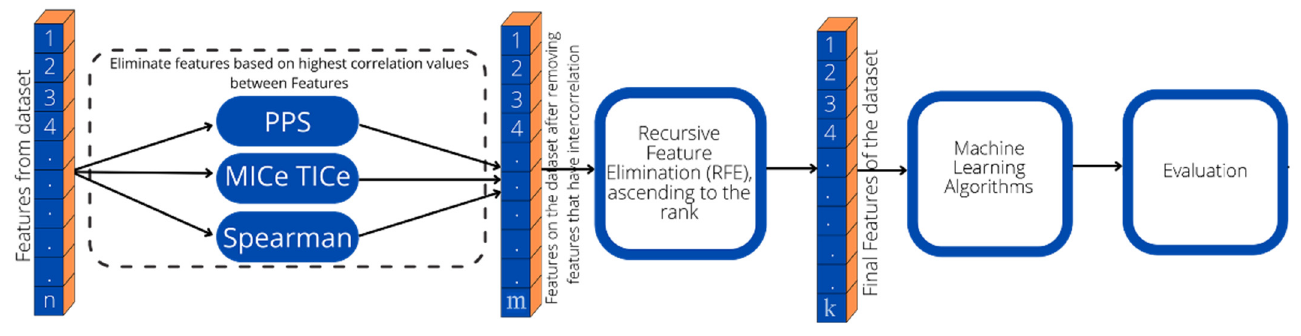
Figure 1. Feature selection and elimination approach from this method.